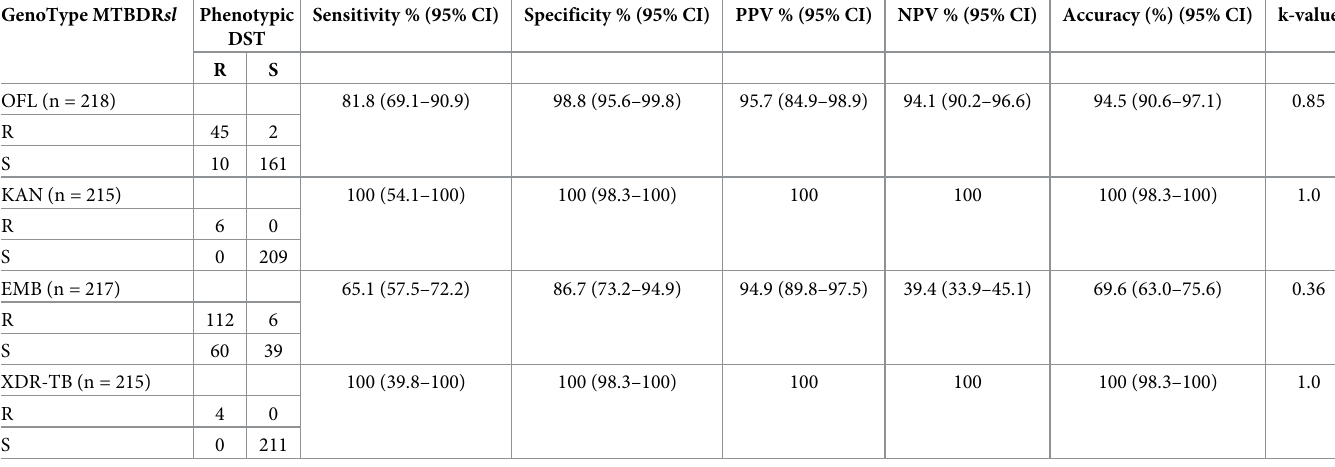
Table 3. Diagnostic performance of MTBDR sl assay compared with phenotypic DST method for detection of OFL, KAN, and EMB susceptibility. GenoType MTBDR sl Phenotypic DST